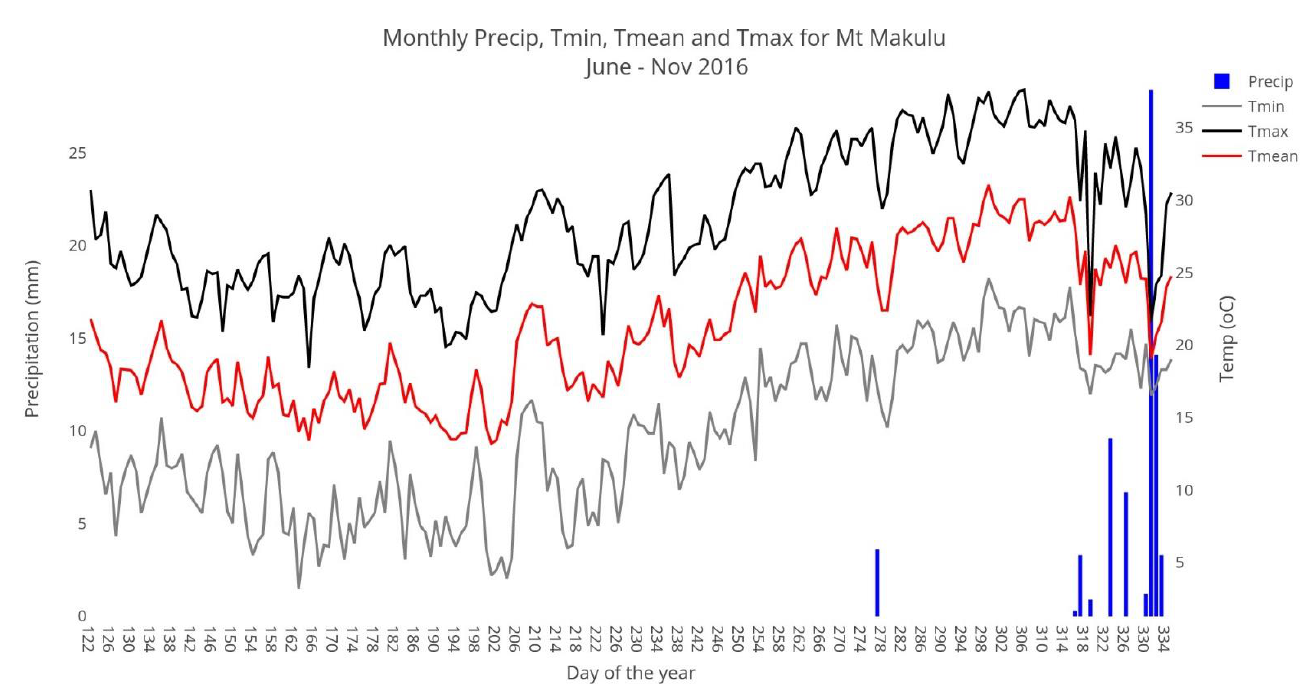
Figure 2. Daily weather data (June – November 2016) collected during the irrigated field experiment at Mount Makulu.